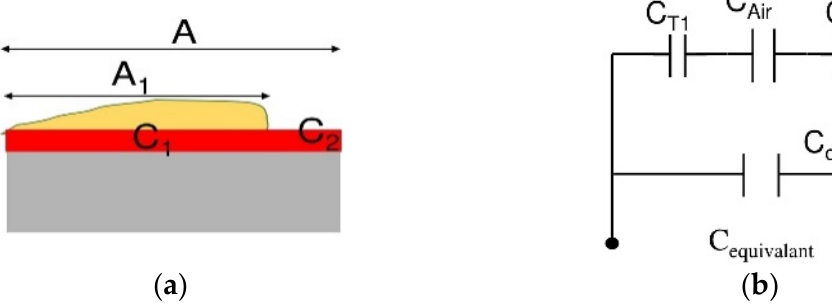
Figure 3. ( a ) Simplified model for the attachment of the cells on the electrodes after complete evaporation of the sample; ( b ) Equivalent circuit model.